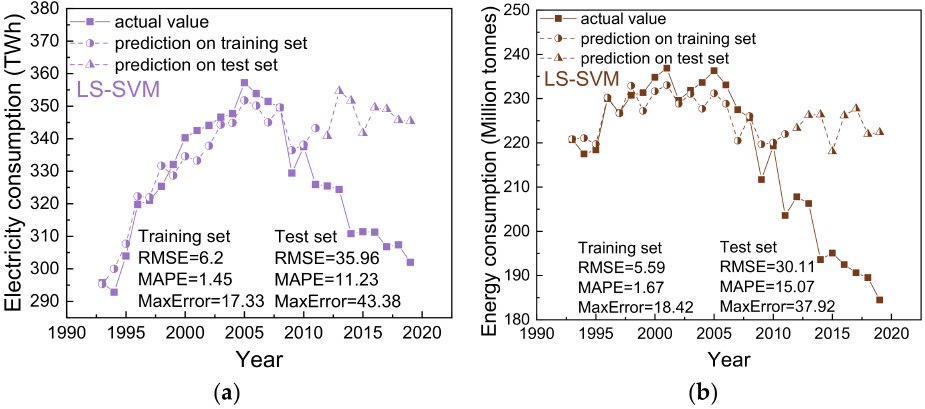
Figure 7. Results of LS-SVM model. (( a ) electricity consumption; ( b ) energy